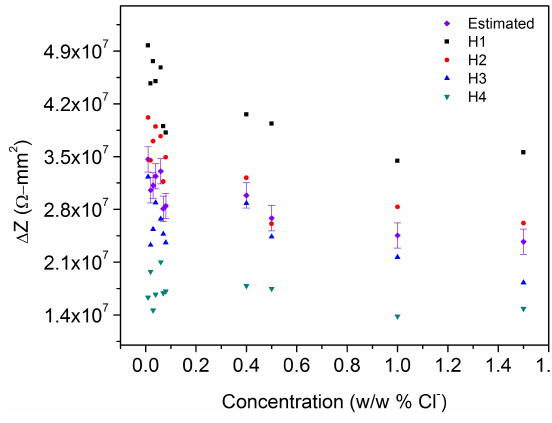
Figure 15. Chloride concentration effect on ∆ Z according to the chamber where the measurement was taken, the frequency is f = 60,016